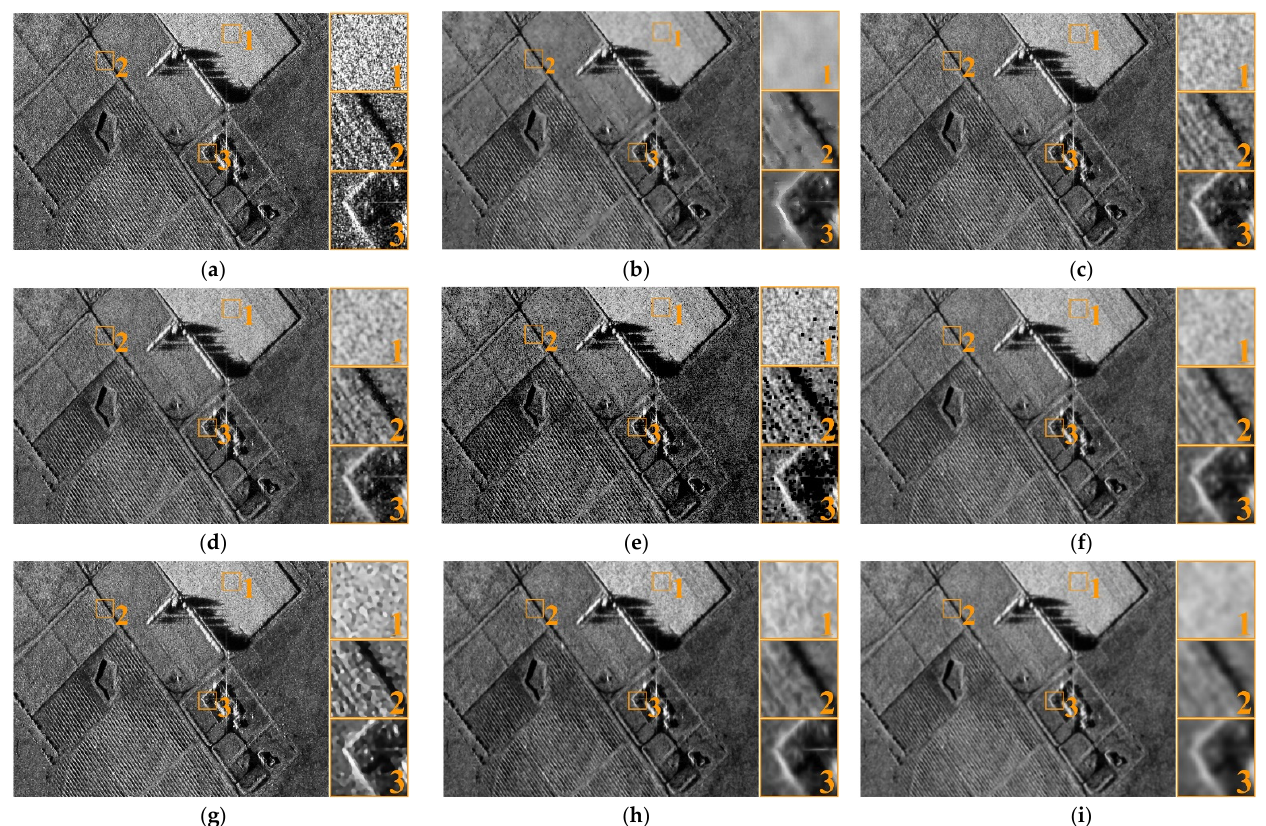
Figure 17. Experimental results on the Ku-band SAR image: ( a ) is the original image, and ( b – i ) are filtered results of our method, Lee filter, traditional Frost filter, SRAD, NLM, RGF, EDS, and SAR- IRGF, respectively.